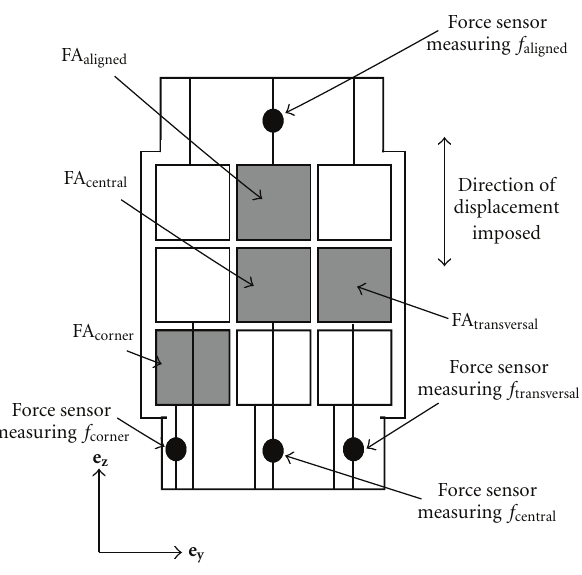
Figure 4: Force sensors disposition.